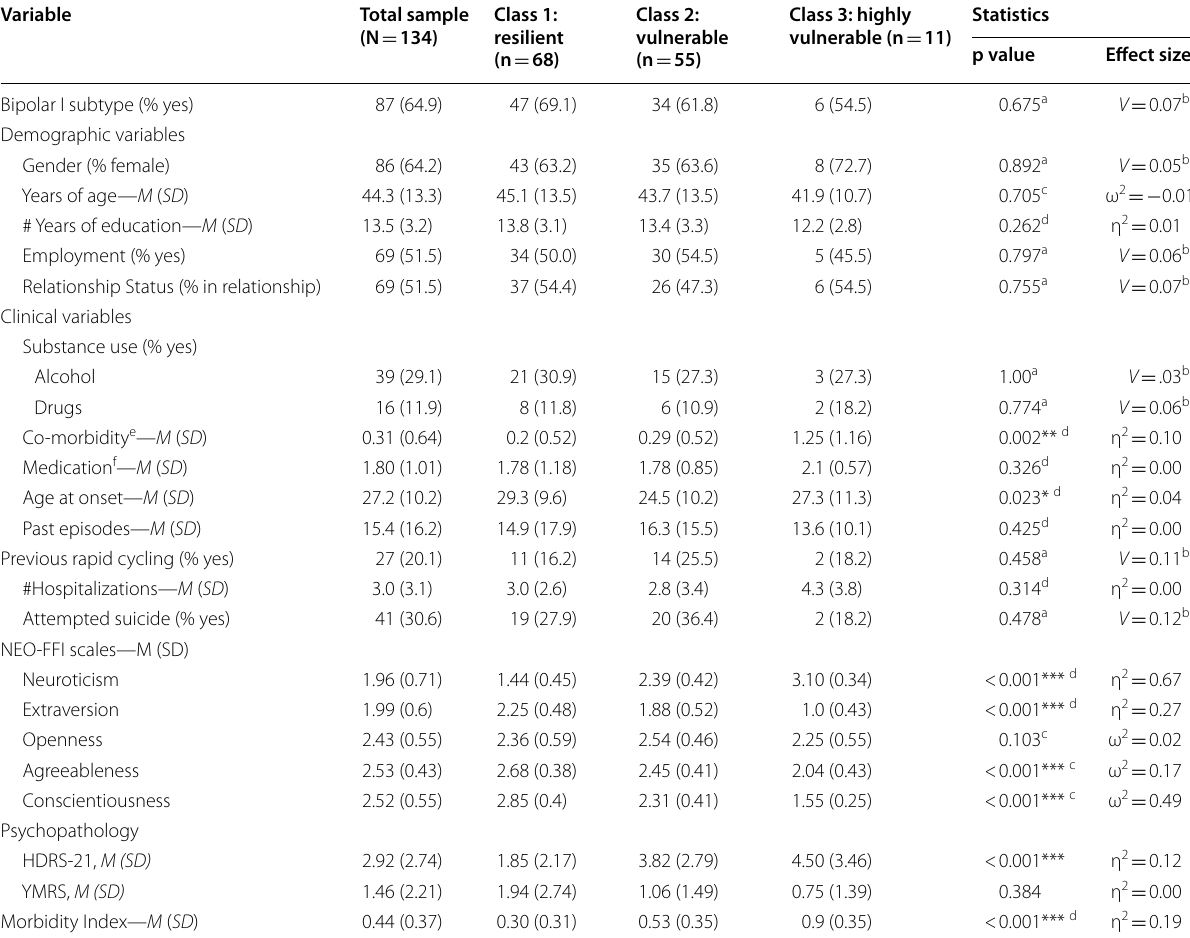
Table 1 Sample characteristics and differences between personality